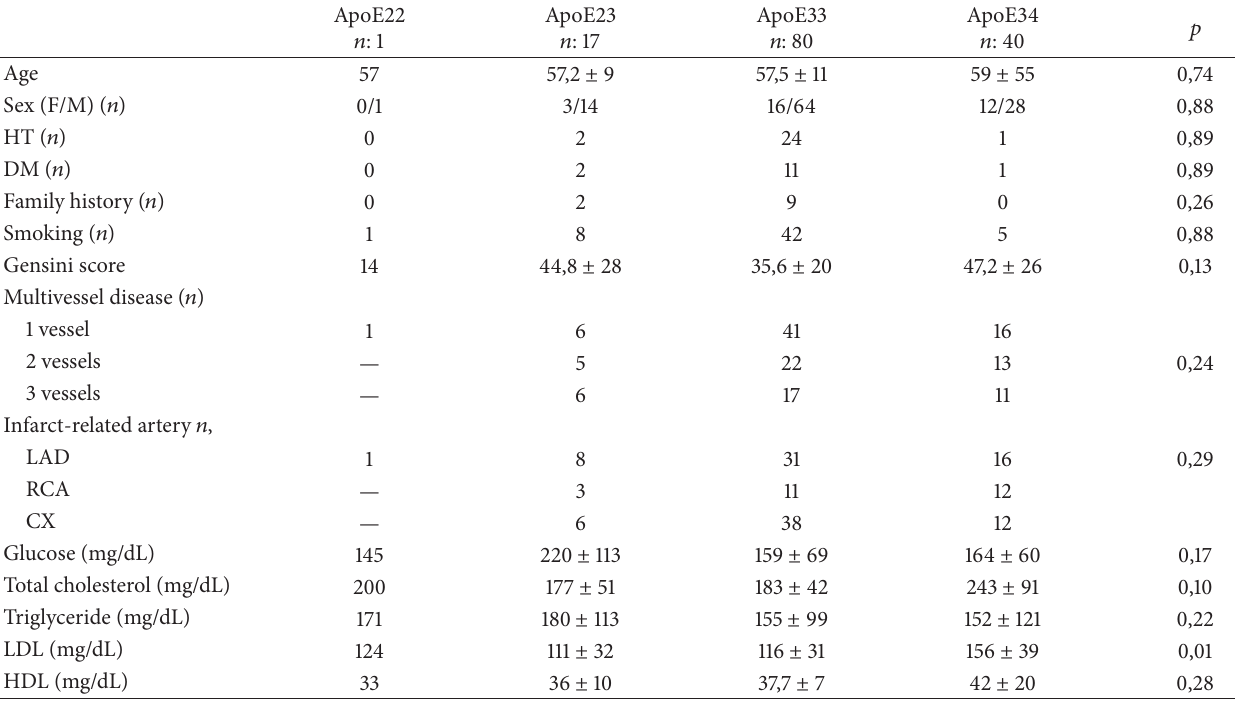
Table 1: Demographic characteristics and distribution of lipid parameters of the patients according to ApoE genotype.